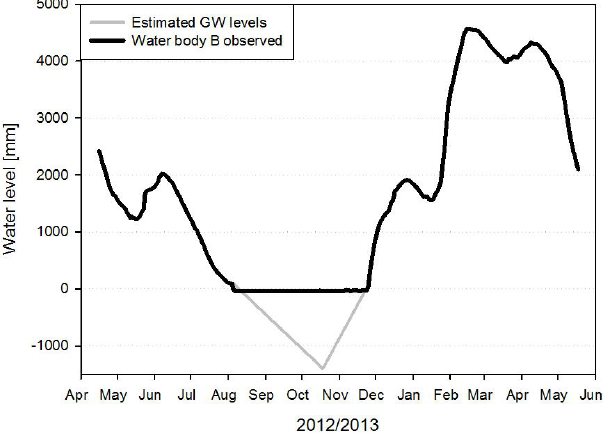
Figure 7: Predicted AET to PET ratios for all water bodies 2 Figure 7. Predicted AET to PET ratios for all water